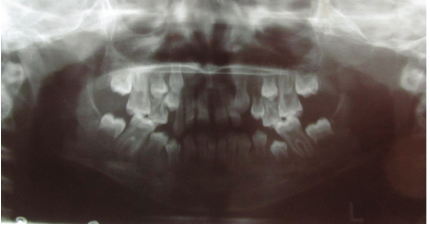
Figure 6: Showing orthopantomogram with apical involvement of 36 and